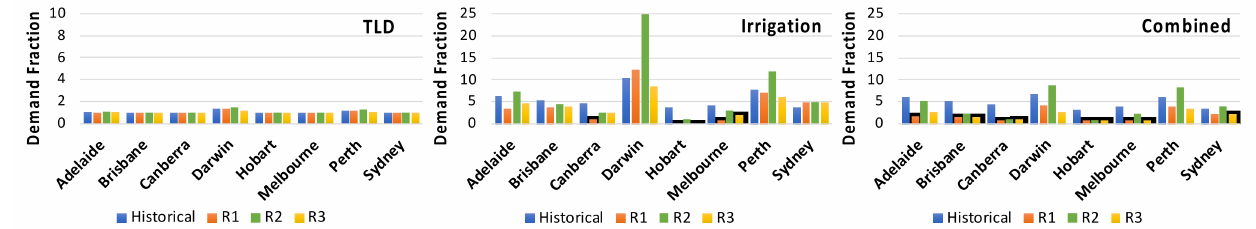
Figure 6. Demand fraction values for all the 8 locations for both the historical and future periods (TLD, irrigation and combined